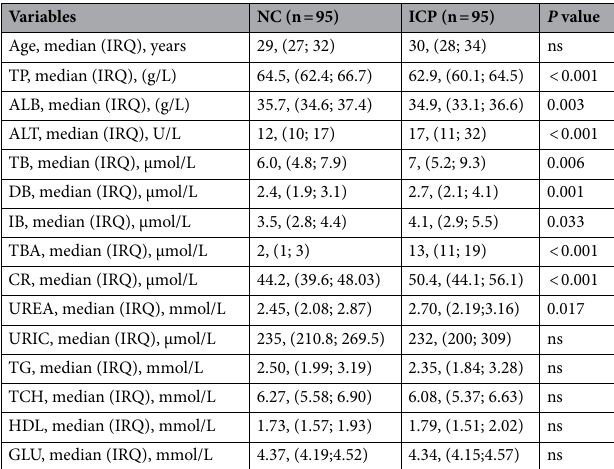
Table 1. Baseline characteristics of 190 participants according to ICP diagnosis,